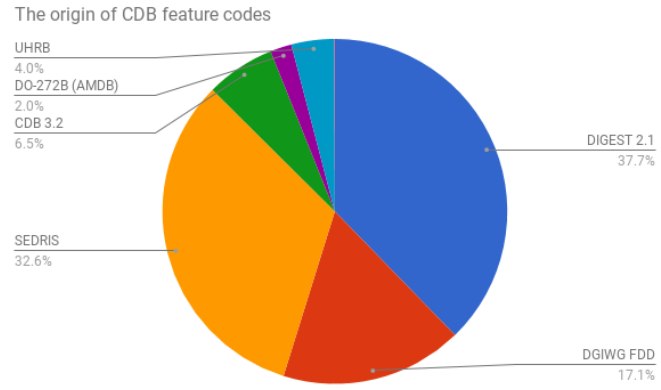
Figure 6. The origin of CDB feature codes.